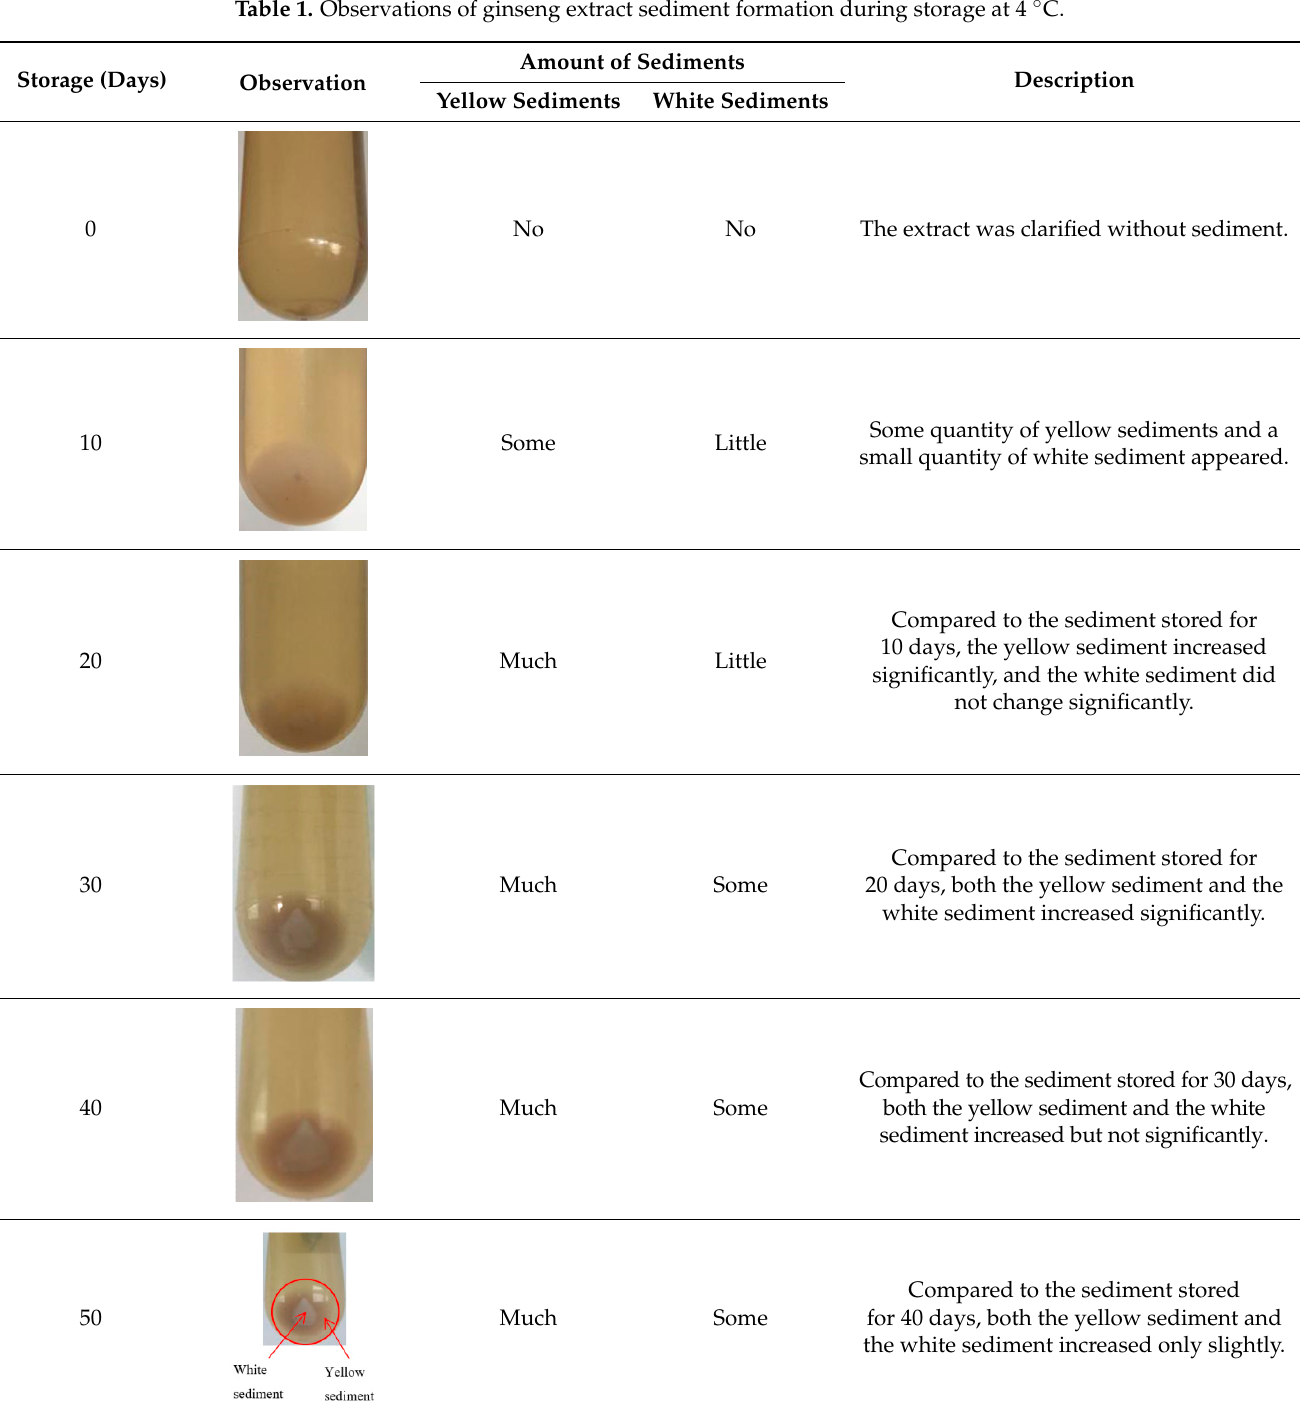
Figure 1. Total sediment (TS), reversible sediment (RS) and irreversible sediment (IRS) of ginseng extract during storage at 4 °C. The data are means of three replicates. Different letters in the column groups indicate a significant difference ( p < 0.05). Table 1. Observations of ginseng extract sediment formation during storage at 4 °C.